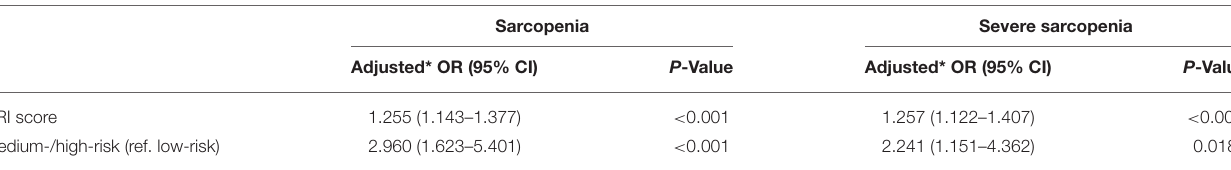
TABLE 5 | Association of nutritional status with sarcopenia and severe